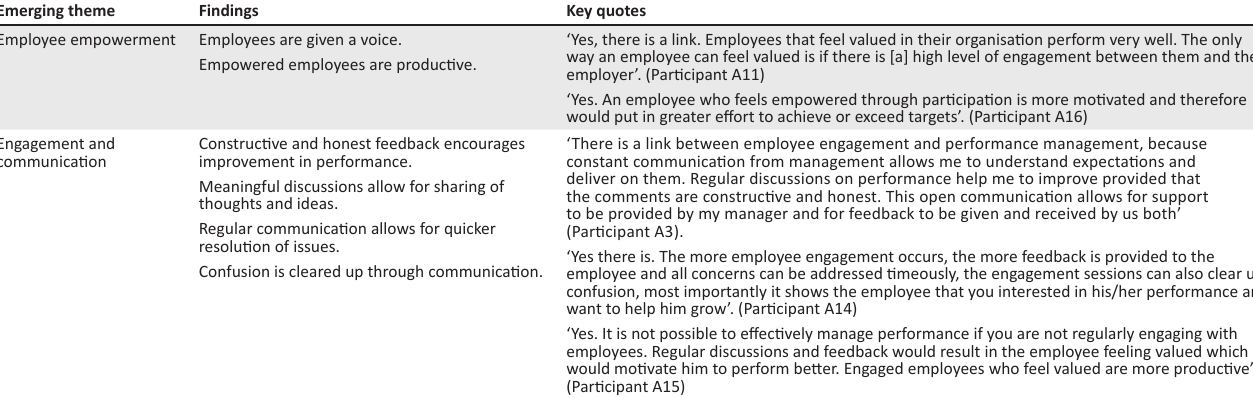
TABLE 7: Summary of findings for question 3 – Employee engagement. Does a relationship exist between employee engagement and performance management? Emerging theme